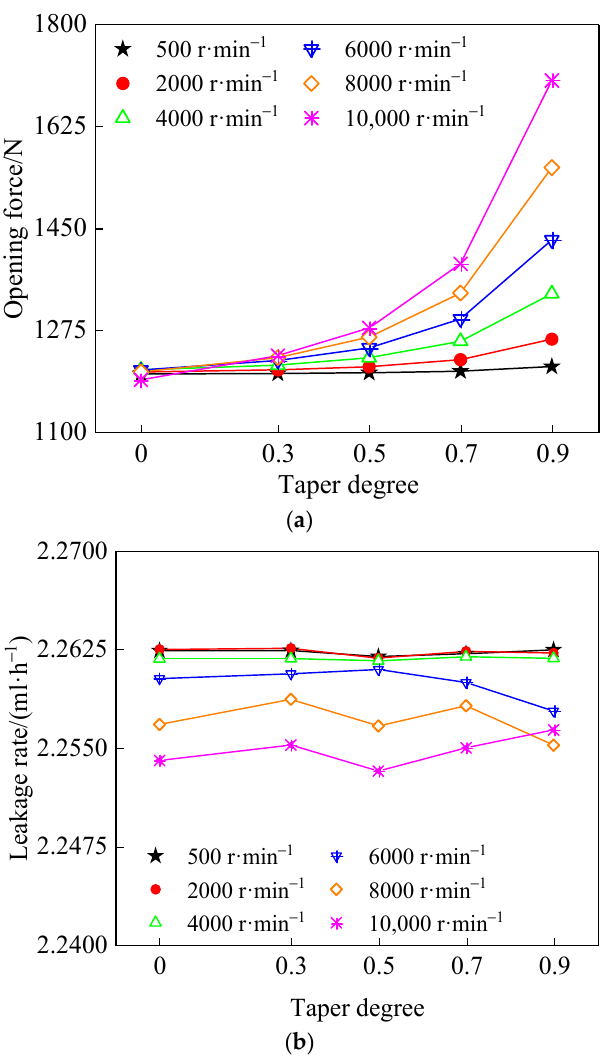
Figure 9. Influence of the diffuser groove taper degree on its sealing performance: ( a ) Influence on the opening force; ( b ) Influence on the leakage rate. ( r k = 34 mm, h ki = h g = 50 μ m, r o = 30.6 mm, N g = 32, γ = 0.5, α = 30°, Δ p = 0.5 MPa).